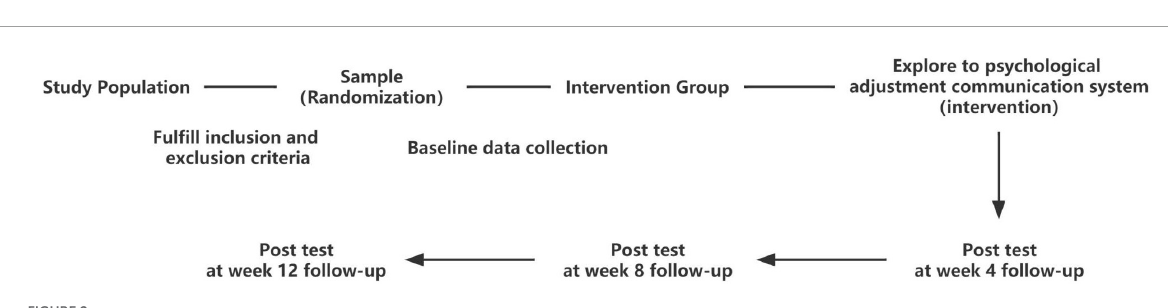
FIGURE2 Consort diagram for the experimental study on the psychological adjustment communication system intervention’s